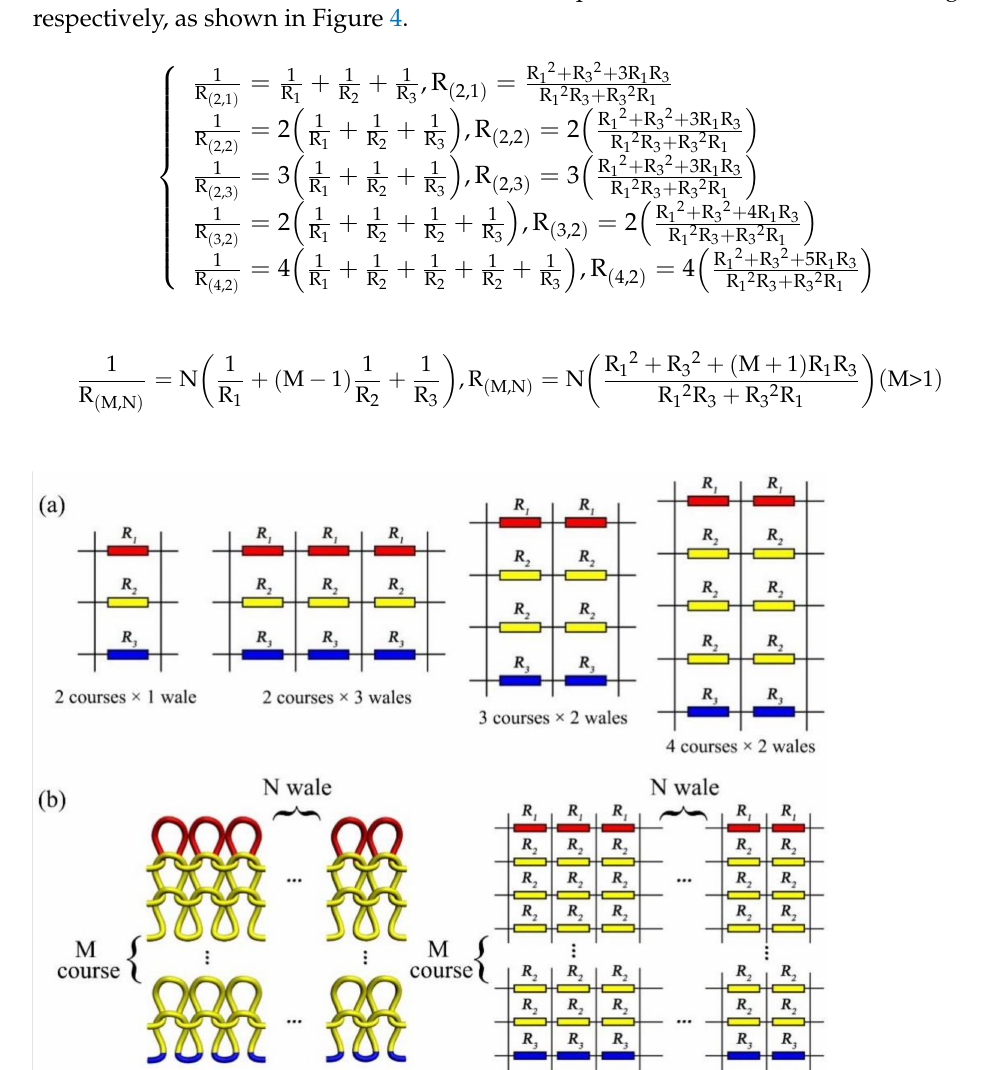
Figure 4. ( a ) 2 courses × 1 wale, 2 courses × 3 wales, 3 courses × 2 wales, and 4 courses × 2 wales equivalent circuits; ( b ) The equivalent circuit of M course × N